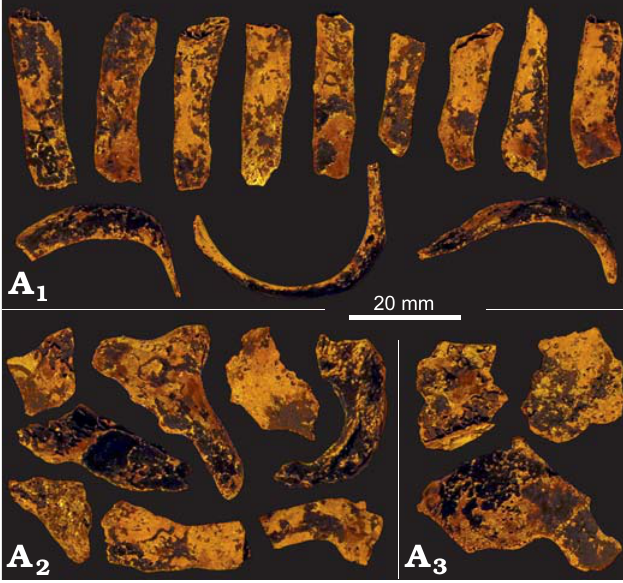
Fig. 2. Tracheal cartilages of glyptodont mammal Panochthus sp. (MHM-P 87) from the Late Pleistocene of General Belgrano, Argentina, in ventral ), ventral and ventro-lateral (A views. Lateral (A 1 ) in ventral cricoid cartilage (A 3